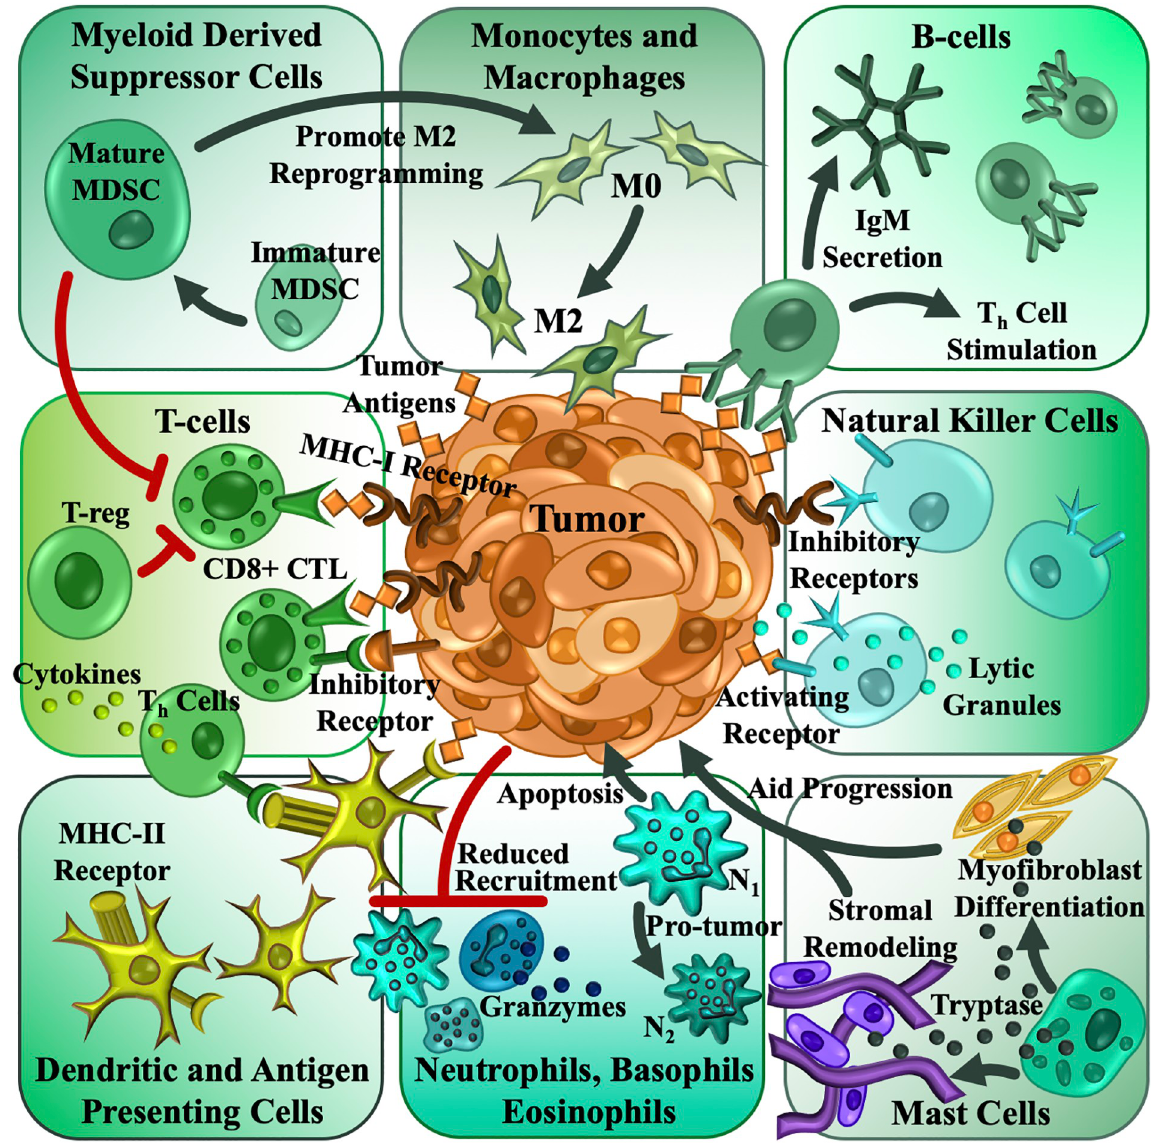
Fig 4. The immune microenvironment of tumors contains cellular components from both the innate and adaptive immune systems, with functional immuno-modulation between all the different cell types. Macrophages are typically the most abundant population of leukocytes within the TME, derived from both tissue-resident and circulating monocytic progenitors. The accumulation of tumor-associated macrophages is often correlated with the development of pathological phenotypes in cancer, which leads to the promotion of angiogenesis, metastasis, chemoresistance and functional suppression of adaptive immunity. The TME counterbalances activating natural killer (NK) cell signals with strong inhibitory signals to escape NK cell mediated immune surveillance and further reduce the phagocytic activity of NK cells. NK cells also exhibit functional anergic phenotypes with reduced phagocytosis and reduced amounts of cytoplasmic granules that contribute to tumor progression. Other granulocytes within the TME often recruited from circulating vasculature include neutrophils, basophils, eosinophils and mast cells. Tumors often experience reduced recruitment, but granulocytes are often re-programmed to a pro-tumor phenotype, promoting vascular normalization and stromal remodeling. Analysis of several solid tumors also indicate that they are infiltrated with T-cells and B-cells, recruited from circulating blood and lymphatic structures. The number of infiltrated T-cells offer significant prognostic value to cancers. However, the TME reprograms T-cells into an exhausted anergic state, leading to severe immune suppression, specifically of the Th and CTL (CD8+ cytotoxic T lymphocytes) phenotypes. Additionally, recruited naive T-cells are also converted to an insidious regulatory Treg phenotype, which contributes to suppressive immunomodulation. B-cells typically respond to tumor-derived antigens and elicit antibody responses through IgM secretion and direct stimulation of Th cells. Tumor-educated B-cells are immuno-suppressive, promote regulatory T-cells, and promote carcinogenesis. Myeloid derived suppressor cells are heterogeneous mixes of immature myeloid cells, found accumulated in lymphoid structures, blood, and the TME, and are heavily correlated with immune suppression. Myeloid derived suppressor cells are powerful inactivators of T-cells. Impaired myeloid differentiation also results in defective antigen presentation. Coupled with dysregulated T-cell priming by antigen presenters like dendritic cells, an overall immune suppressive landscape leads to tumor escape from immune surveillance.